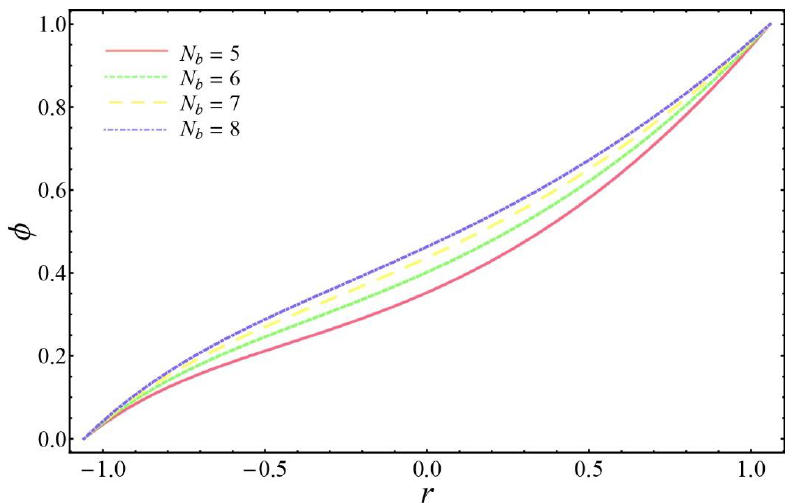
Figure 8. Alteration of N b on φ when x = 0.1; t = 0; Q = 10; β = 0.2; (cid:15) = 0.1; N t = 10; N d = 2; k = 2.